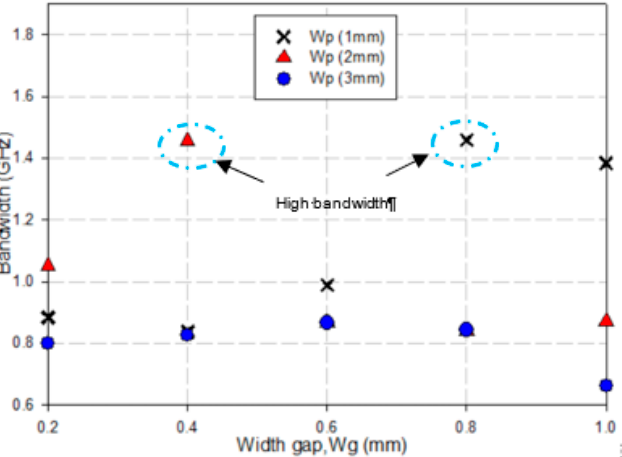
Figure 3. Antenna bandwidth for various widths, Wp, and gap distances, Wg.